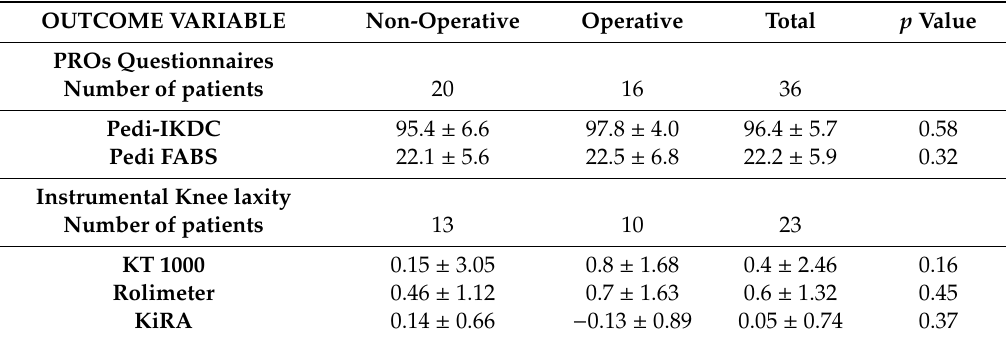
Table 3. Patient-reported questionnaires outcomes and instrumental knee laxity measurements.